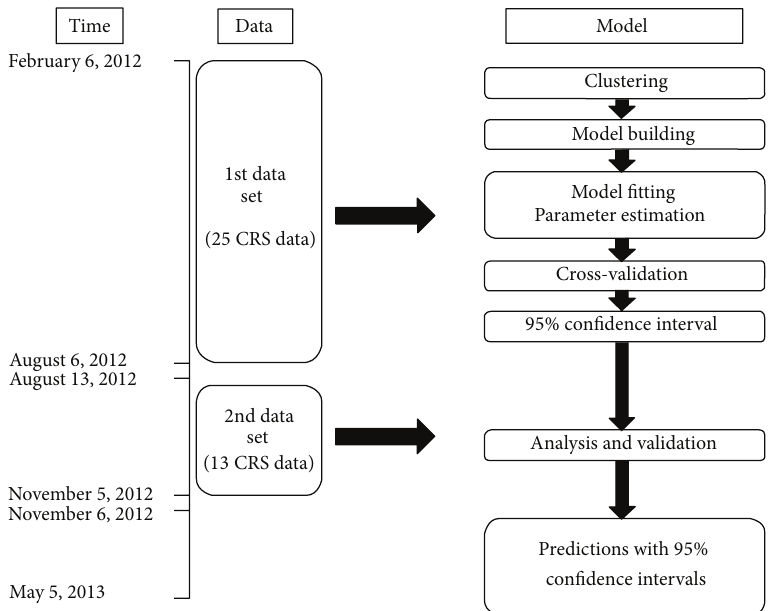
Figure 1: Scheme summarizing the techniques applied through this paper.